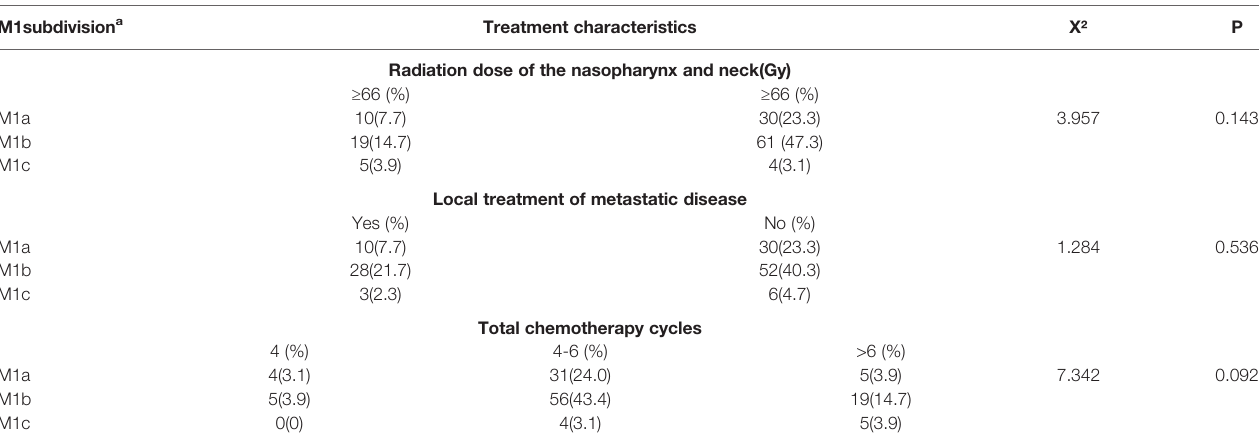
TABLE 3 | c 2 -test analysis of the patient distributions in different treatment modes. M1subdivision